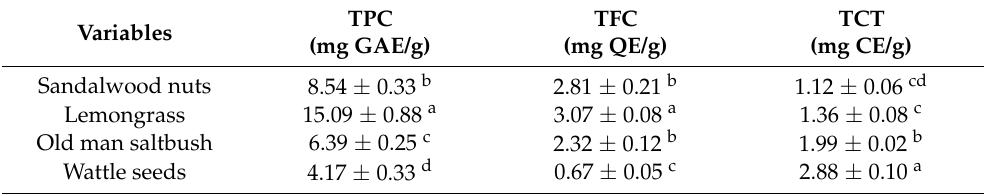
Table 1. Total polyphenol contents of Australian native plants.